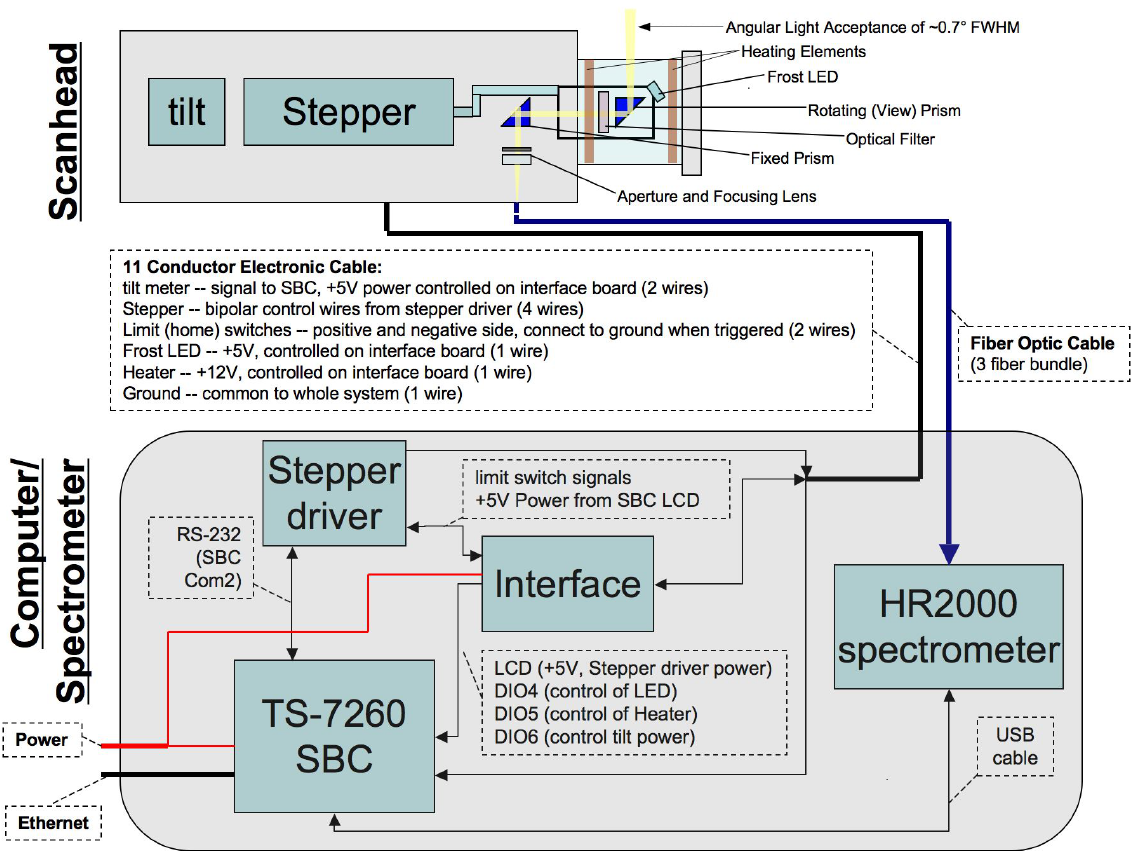
Fig. 1. Schematic of new MAX-DOAS system. The scan head (top) is connected to the computer/spectrometer (bottom) by a fiber optic cable and electronic